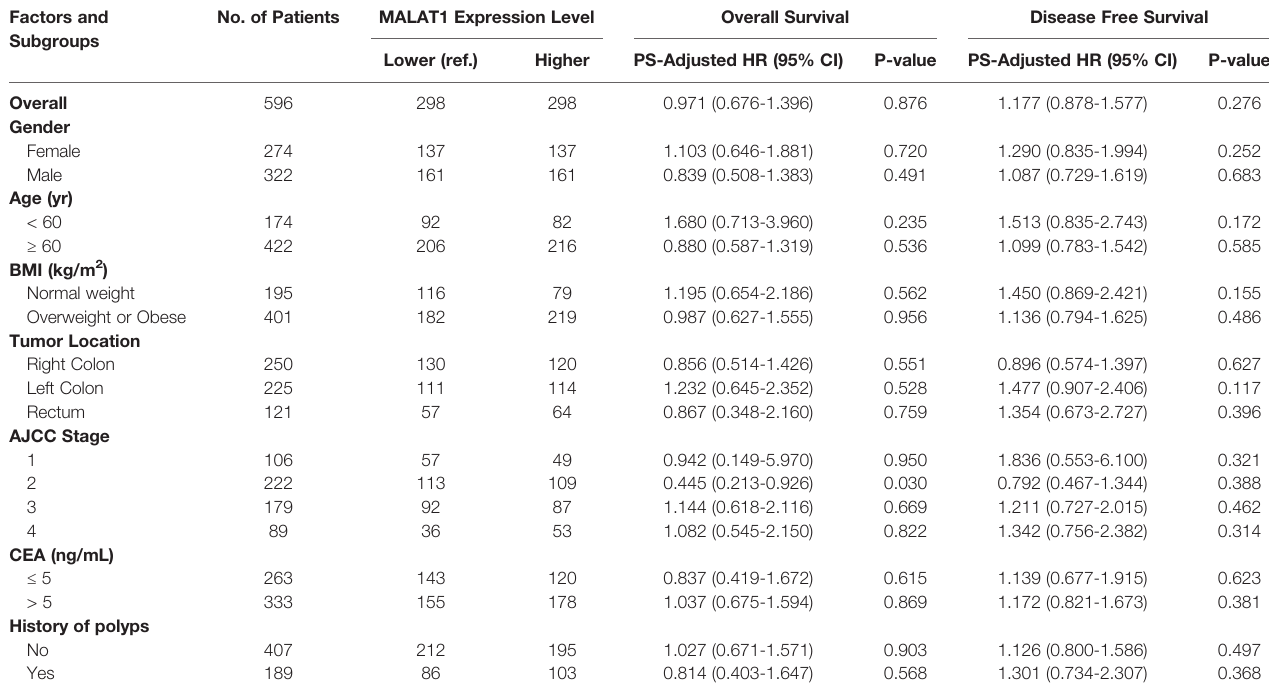
TABLE 2 | Prognostic associations of MALAT1 expression and colorectal cancer outcomes in the external validation population. Factors and Subgroups